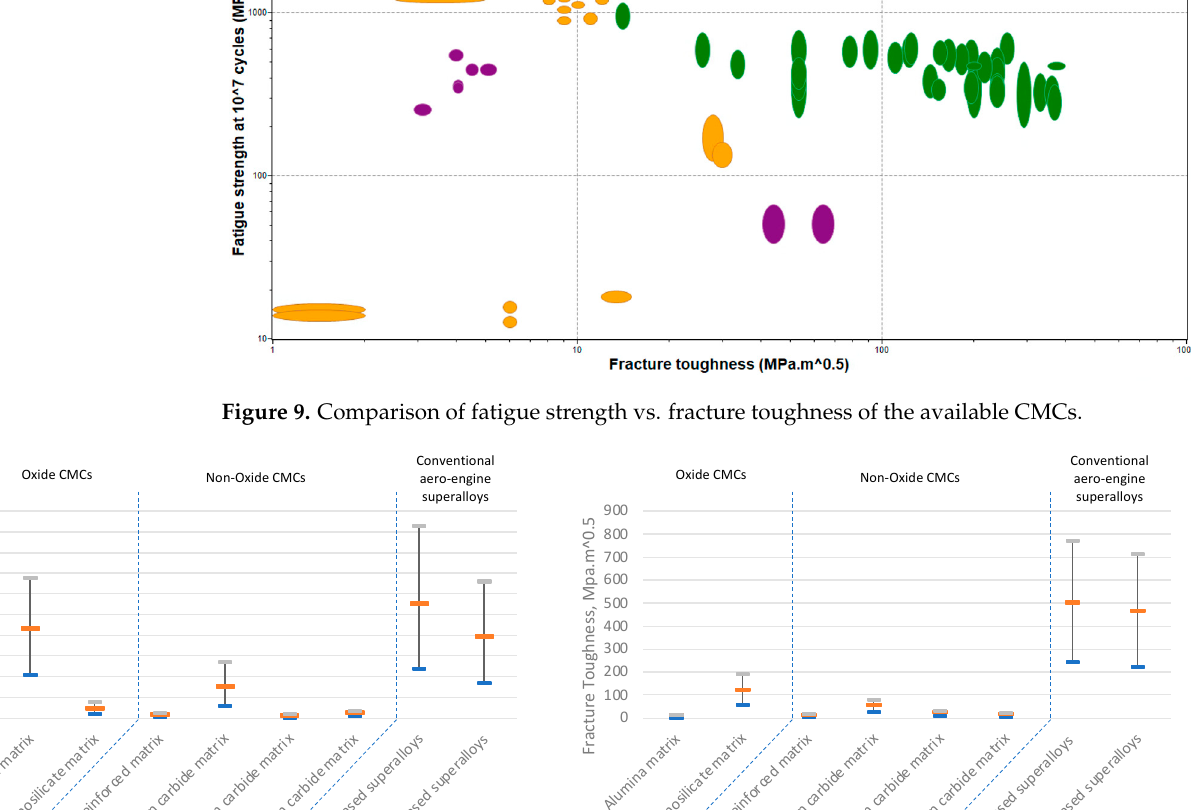
Figure 9. Comparison of fatigue strength vs. fracture toughness of the available CMCs .